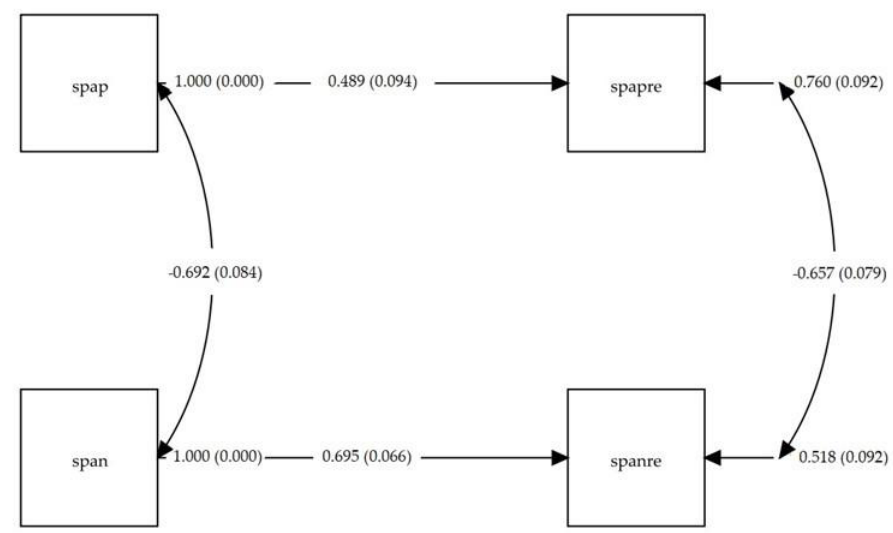
Figure 2. Path diagram of the test–retest model for the Scale of Positive and Negative Experience (SPANE) total scores, with correlations and regression coefficients (standard error); spap: test total score for the SPANE-P; span: test total score for the SPANE-N; spapre: retest total score for the SPANE-P; spanre: retest total score for the SPANE-N. All path coefficients were statistically significant ( p < 0.001).